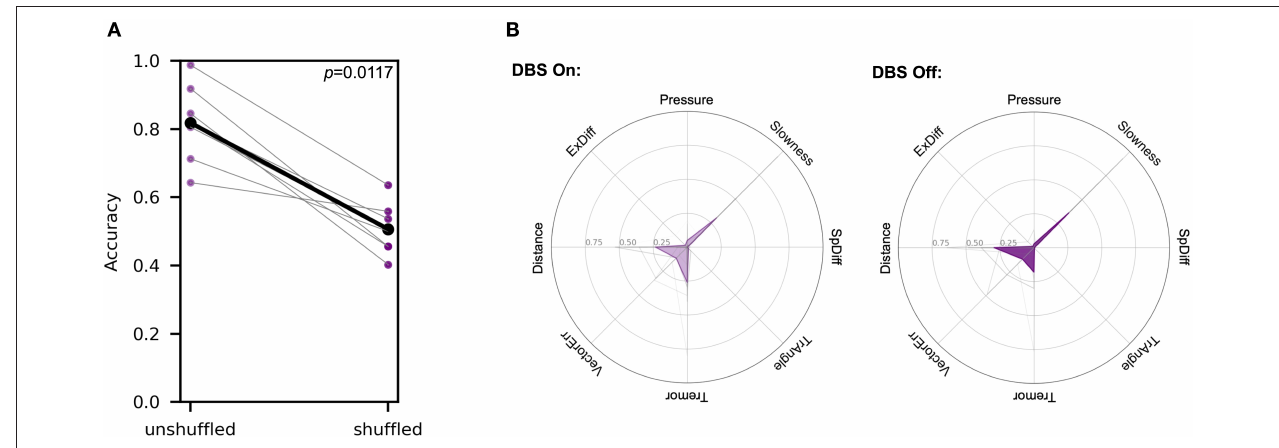
FIGURE 5 | SVM analysis differentiated between DBS states in symptomatic patients. Each patient was tested in both the “DBS On” and “DBS Off” states within the span of 1h. The order of DBS states tested alternated between patients. (A) Accuracies of a single SVM classifier comparing individual patients in two different stimulation states are compared to accuracies produced using an analogous SVM analysis, but with random label shuffling prior to hyperplane generation (Wilcoxon signed rank test, W = 0.0 and p = 0.0117). (B) Metric weights generated by PD patient-pooled control data SVM comparisons were used to examine the relative contributions of each metric in the two different DBS states. The left polar plot depicts the mean metric weights of patients in the “DBS On” state. and the right plot shows the weights of patients in the “DBS Off” state. In each plot, gray lines represent metric weights for individual patients. A two-way ANOVA analysis of these data showed no significant interaction between the metrics and the different movement disorders ( F = 1.966, p =